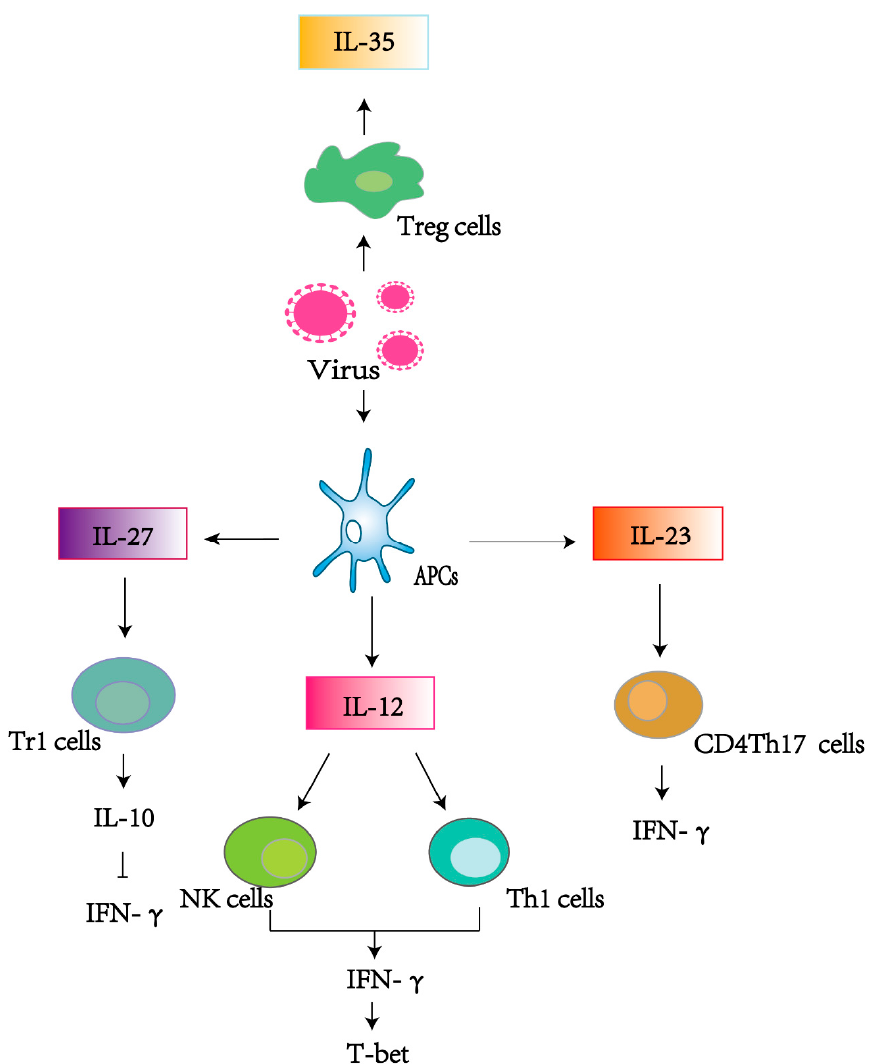
Figure 2. IL-12 family members mediate the immune responses when virus enters into cells. Viral infection contributes to expression of IL-12, IL-23, IL-27, and IL-35 by activating antigen-presenting cells (APCs) or regulatory T (Tregs) cells. IL-12, IL-23, and IL-35 are active in the promotion of inflammatory responses, and IL-27 can function as a kind of anti-inflammatory cytokine. Overall, the IL-12 family of cytokines is indispensable for virus clearance by regulating IFN- γ and other cytokines.